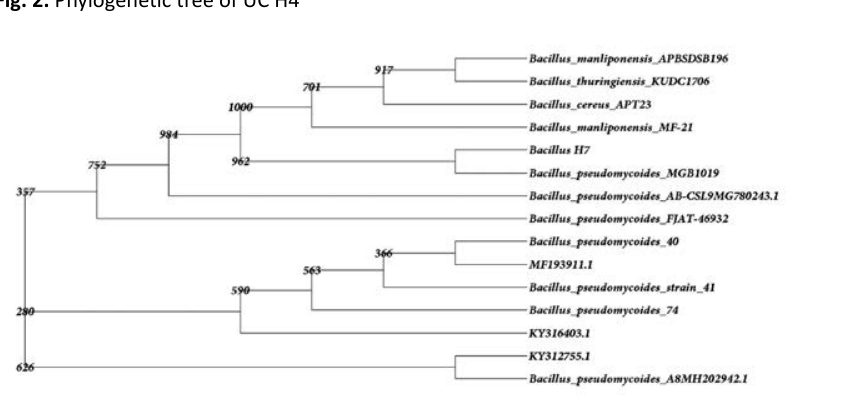
Fig. 2. Phylogenetic tree of UC H4